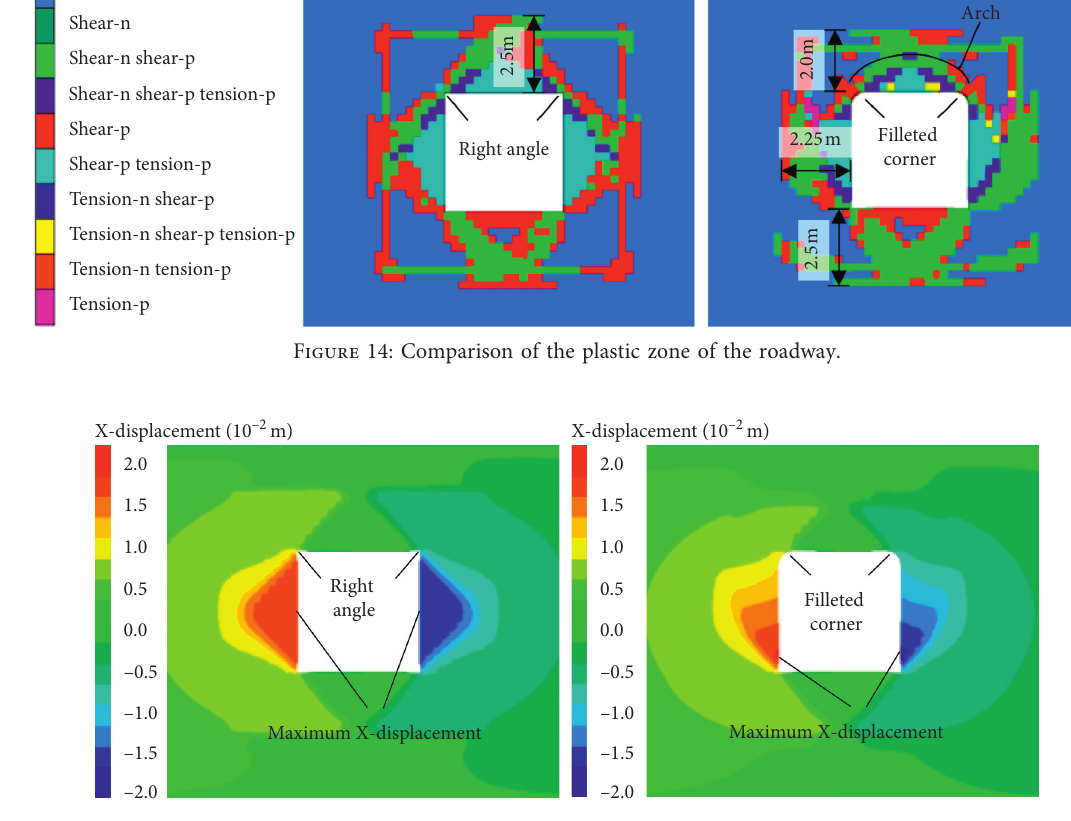
Figure 15: Comparison of horizontal displacement of the